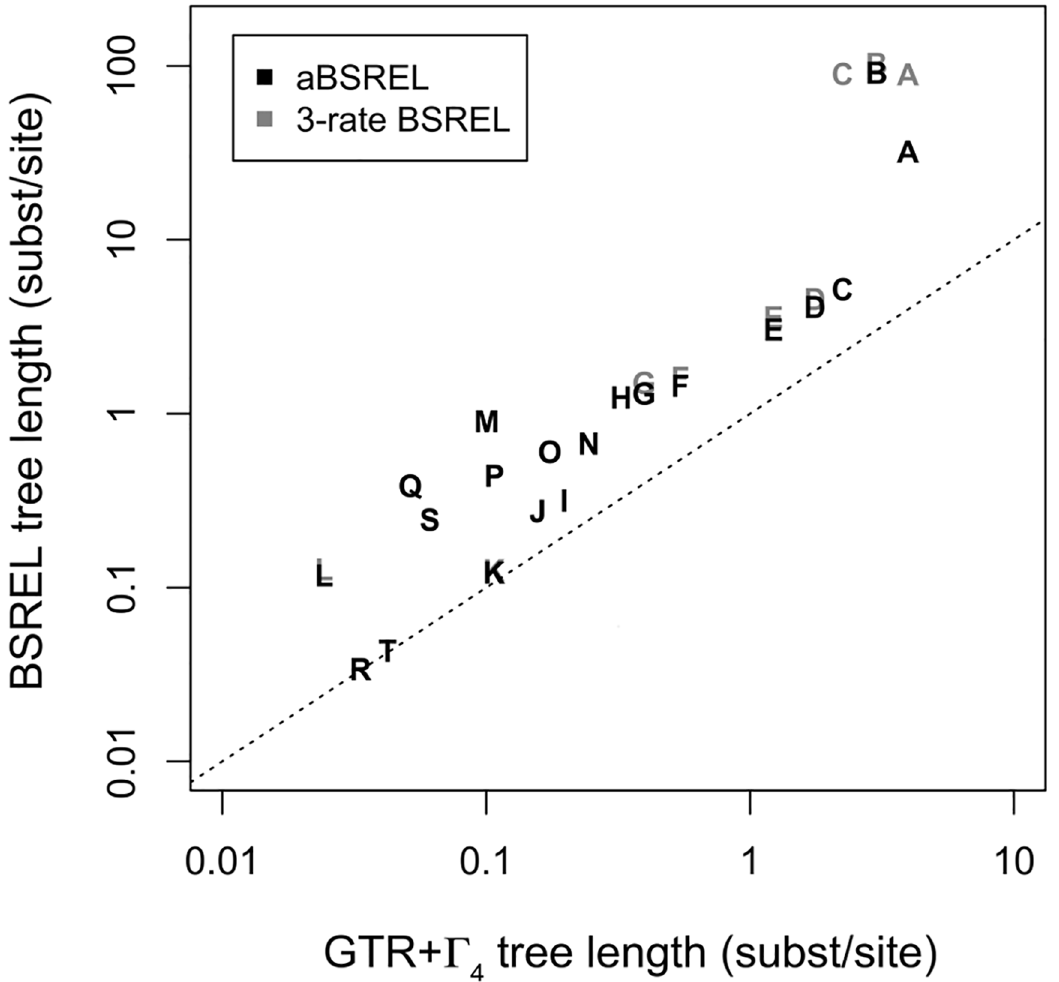
Fig 2. Evidence of branch length underestimation in the VEE complex shown via comparison of tree lengths inferred under Branch-Site REL (BSREL) and GTR+ Γ 4 substitution models. Letters correspondto nodes in maximum likelihood tree. The aBSREL analysisperformed with an optimizednumber of rate classes is shown in black. BSREL analysisperformed with a fixed number of three rate classes is shown in gray. Instances in which only a black letter is shown indicatethat aBSREL and BSREL produced identicalresults. The dashedline depicts x = y, an unbiased analysis.